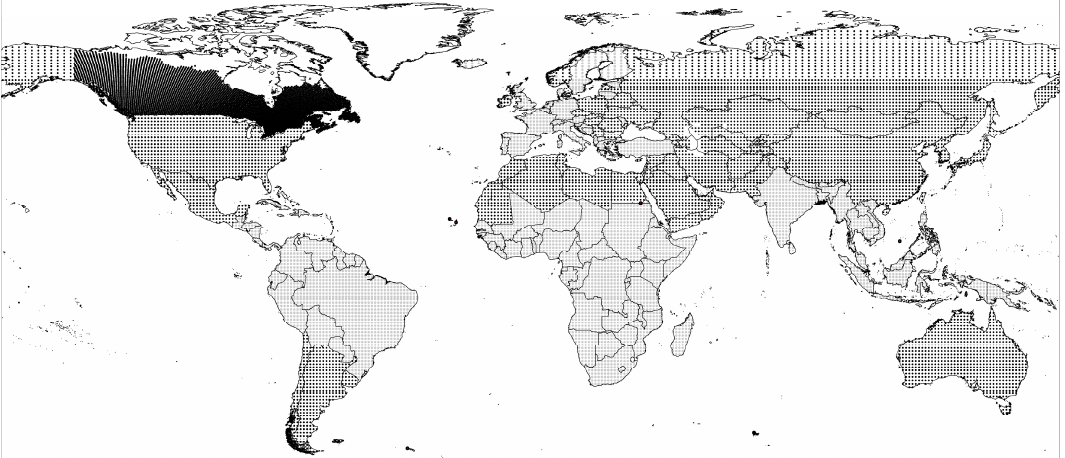
Figure 1. The global, degree grid framework, including the Canadian NFI plot scheme. FAO processing methodology was applied to sites (>11,000) in the boreal, temperate and sub-tropical climatic domains (in black) (From [1]).